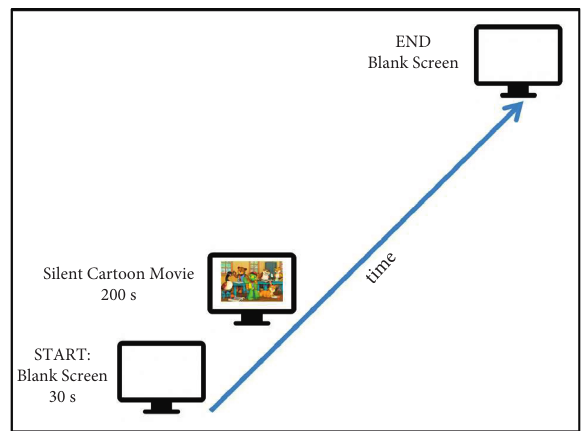
Figure 1: Experimental paradigm.